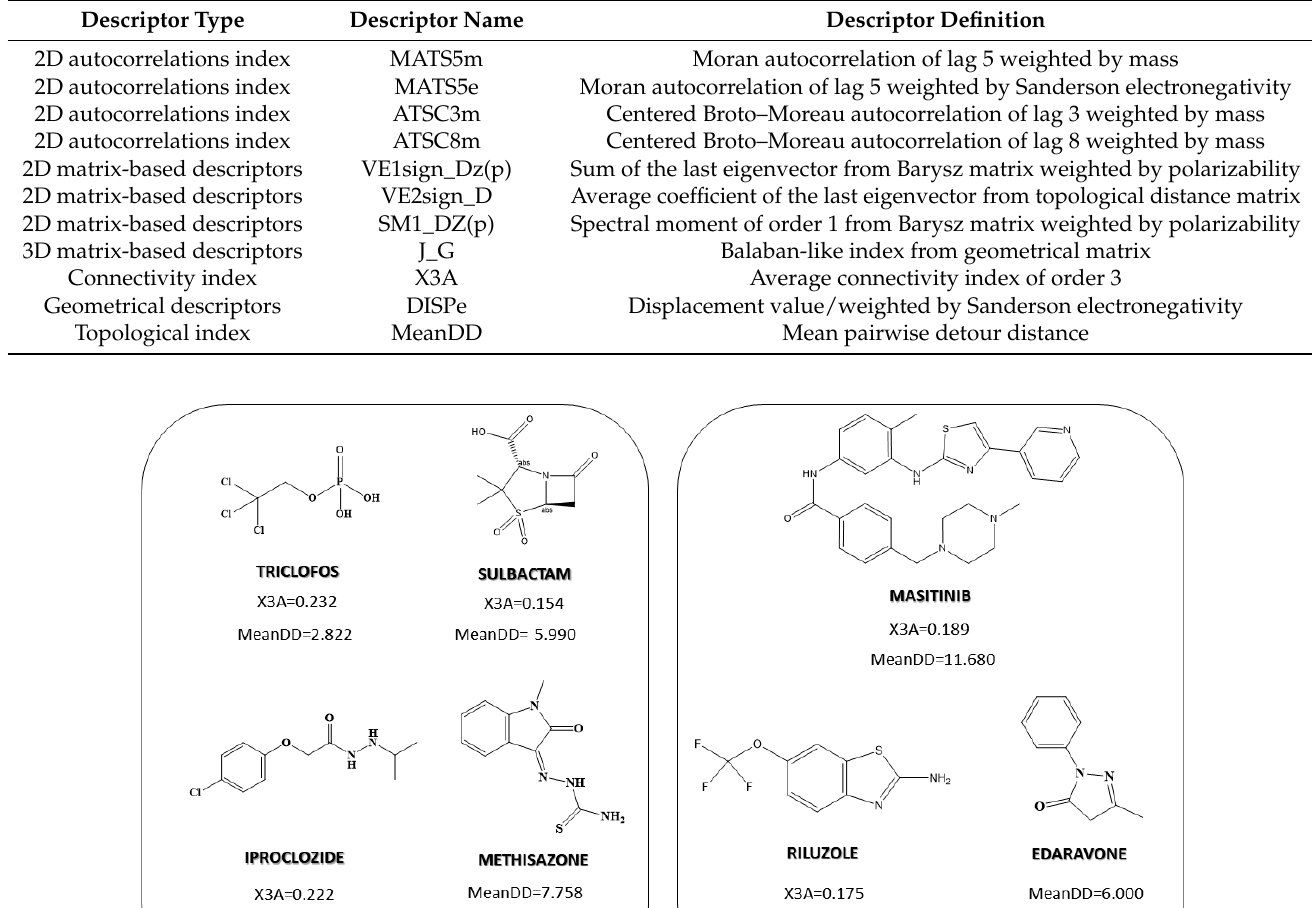
Table 3. Topochemical descriptors used in the construction of ALS models are presented below.